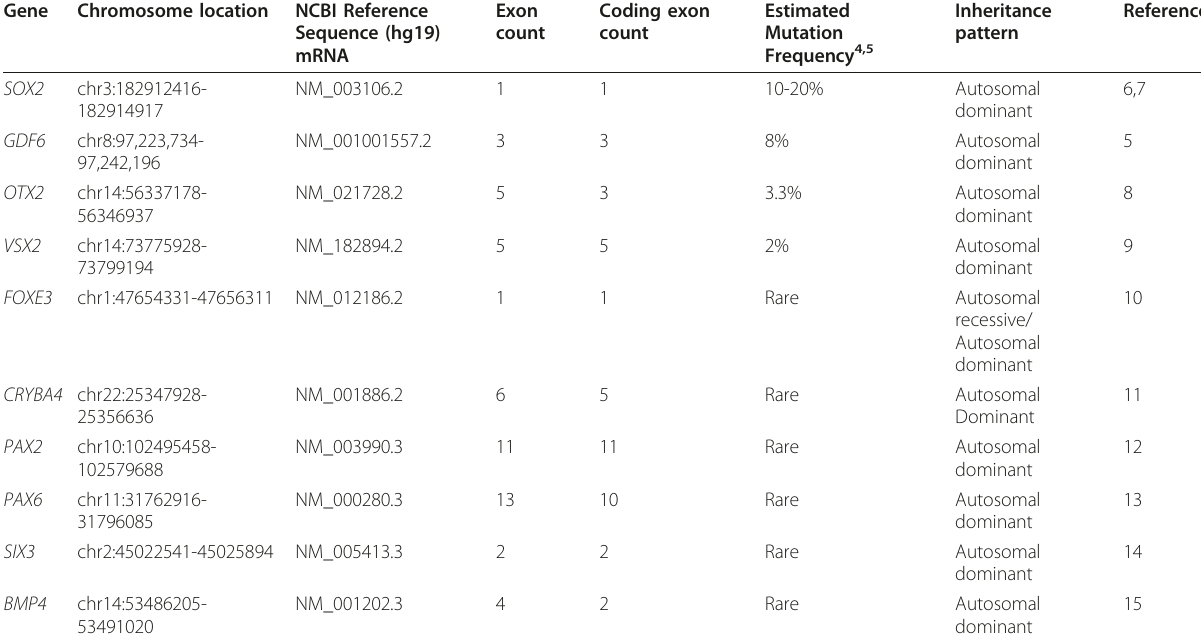
Table 1 Known Anophthalmia/Microphthalmia Genes Investigated by Next-Generation Sequencing Gene Chromosome